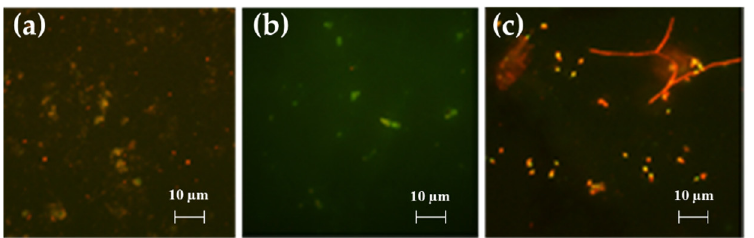
Figure 12. Images of the Gram-negative strain S. maltophilia BC 658 observed with an epifluorescence microscope. ( a ) Control 63×; ( b ) G_A 40×; ( c ) G_A_F3 40×; ( d ) G_A_F16 40×; ( e ) G_A_F3_F16 40×.